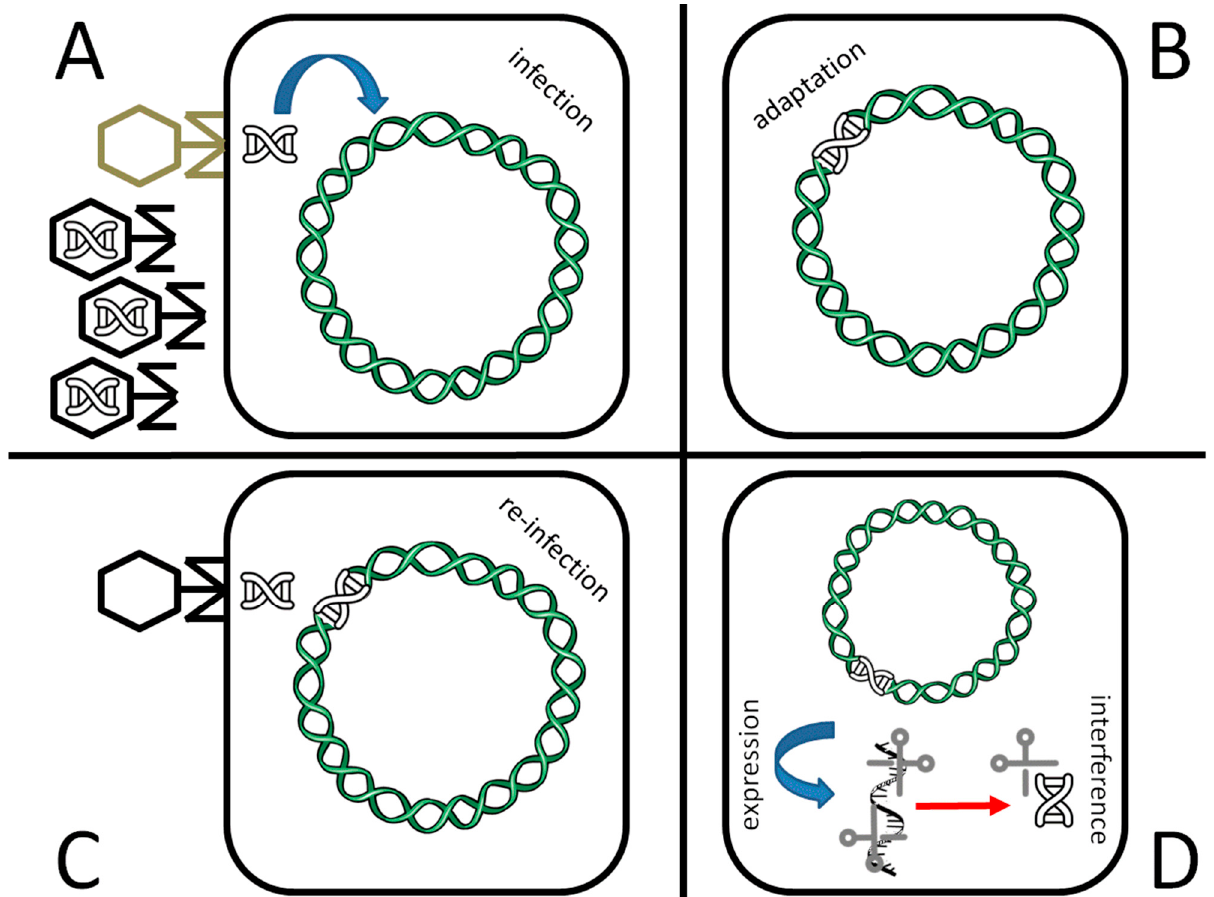
Figure 1. The CRISPR antiviral defense system of prokaryotes. A population of viruses may contain both wild type (black) and defective phages (gray; see text for further explanation). Upon infection of a defective bacteriophage as in the shown example ( A ), part of the viral genome is inserted inside one of the CRISPR loci of the bacterial genome (adaptation, B ). In case of a second infection, even in case of a wild type phage ( C ) the CRISPR locus is transcribed (expression) and promotes viral genome degradation by site-specific, Cas-mediated cleavage (interference, D ).